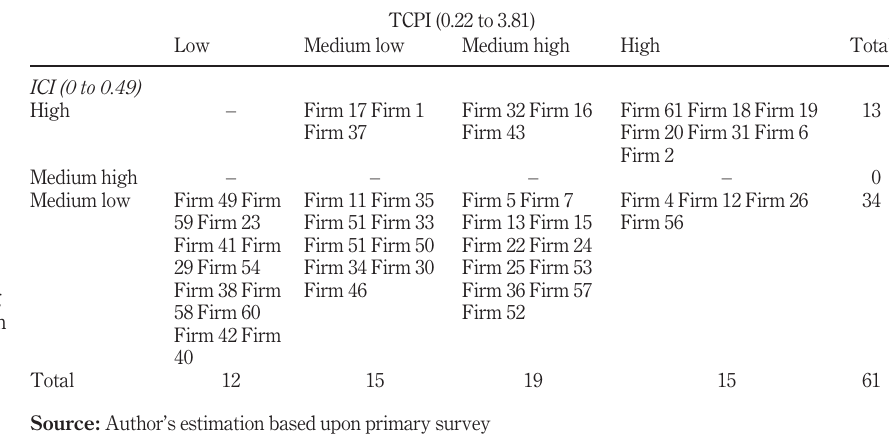
of surveyed fi rms